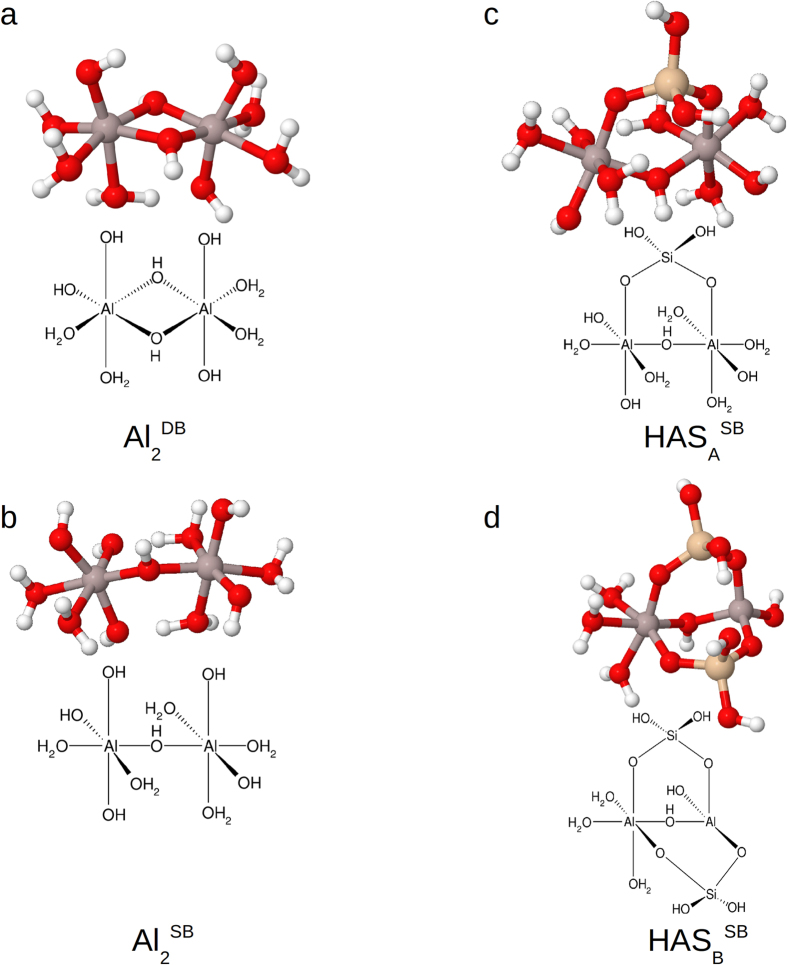
Example aluminium hydroxide and hydroxyaluminosilicate structures tested.(a) Double-bridge Al dimer, (b) Single-bridge Al dimer, (c) Single-bridge dimer b with Si(OH)4 bound at OH groups to form HASA, (d) HASA structure comparable to c, with second Si(OH)4 bound to form HASB, and 2H2O removed from the rightmost Al, leaving it with tetrahedral coordination.